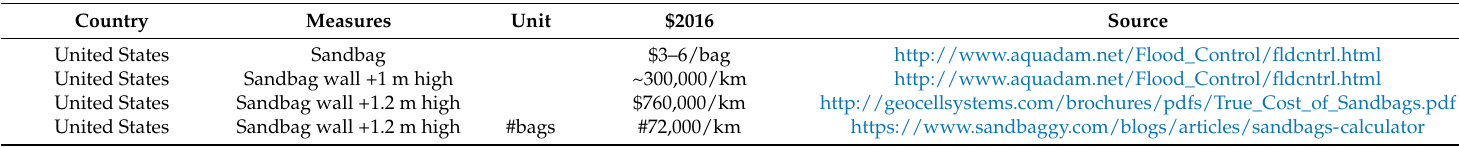
Table A7. Unit cost for sand bags and the sand bag flood